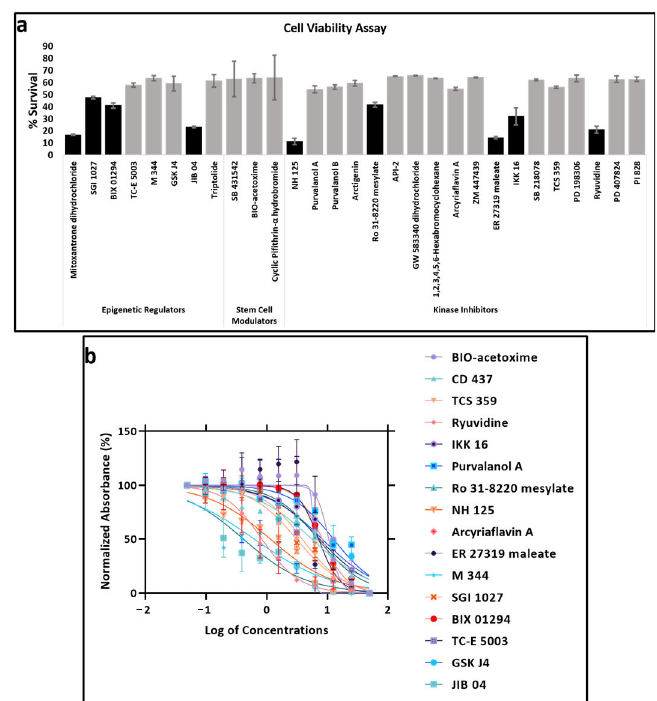
Figure 5. Treatment of KAIMRC2 cell line with kinase inhibitors, stem cell modulators, and epigenetic regulators. Cell viability was assessed by MTT assay. ( a ) Initially, compound panels were tested at 10 µ M concentration. Cytotoxic compounds with a % cell survival of less than 50% were selected (Black bars). ( b ) IC 50 calculation of the selected